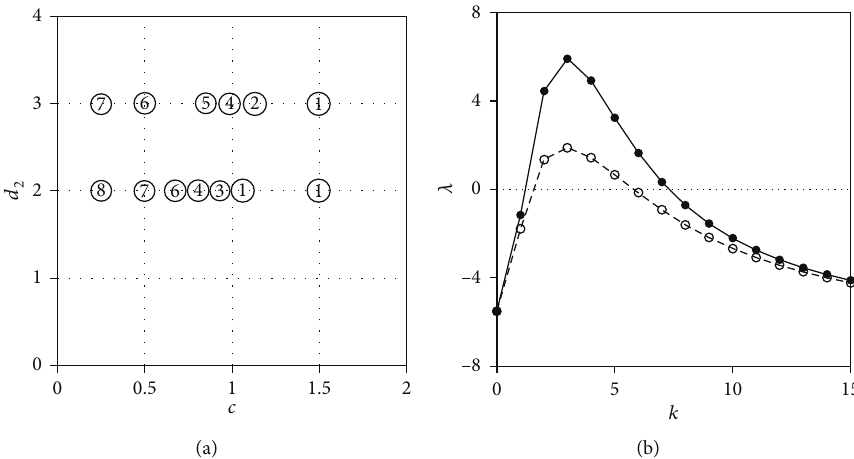
Figure 8: Number of pulses in the KT model (14) in a large system and dependence of eigenvalues on the wave number given by Equation Þ space. Numbers in the fi gure represent the number of the pulses in the system size (19). (a) Dependence of number of pulses in ð c , d 2 L = 60 : (b) Dependence of eigenvalues λ on the wave number k given by Equation (19). Symbols • and ∘ represent eigenvalues in the = 2 and L = 2 case of c = 0 and 0.5, respectively. d 2